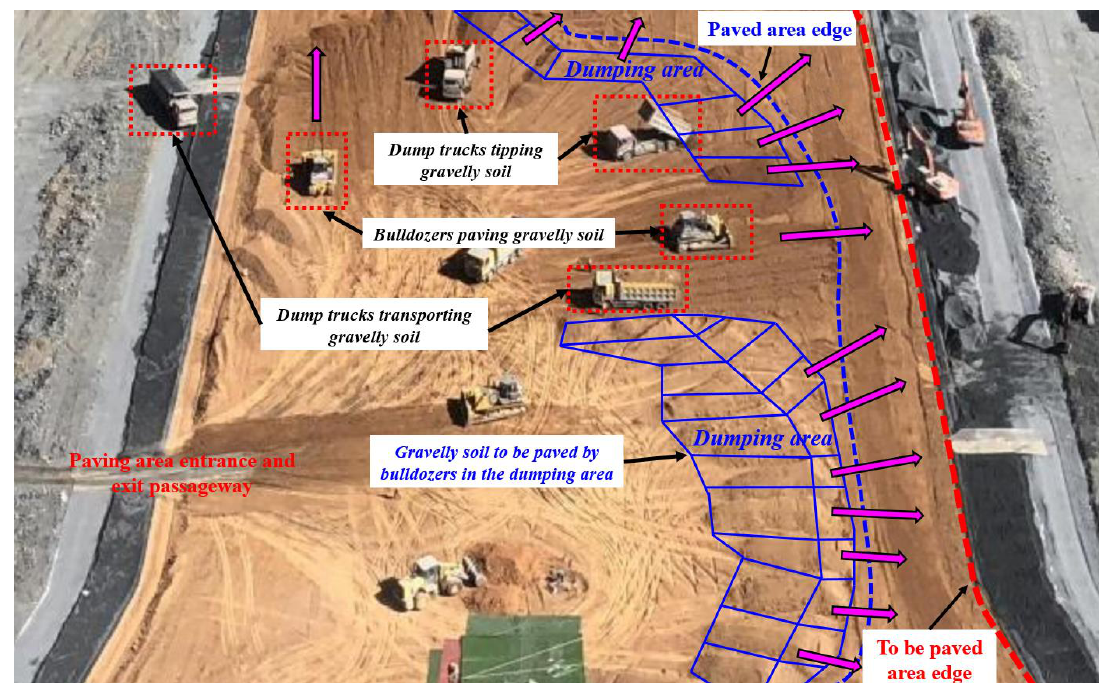
Figure 1. Paving construction process scene in core wall area of earth-rock dam.